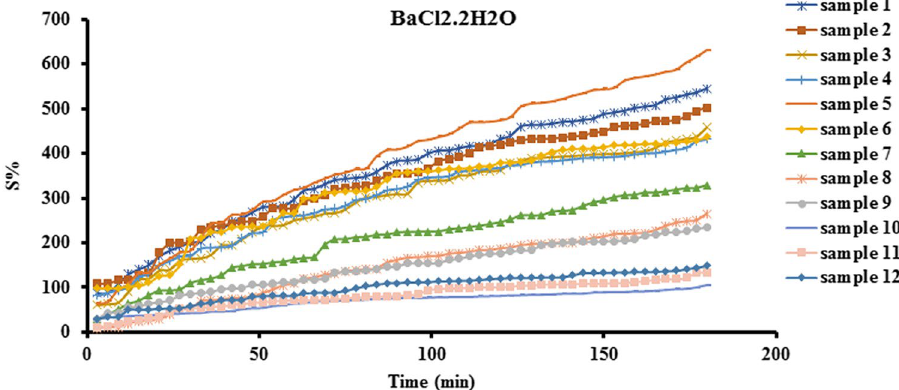
Fig. 4 Swelling changes in PPGs in BaCl 2 ·2H 2 O salt solu- tion over time